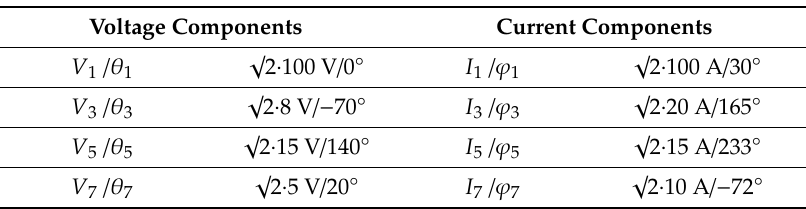
Table 2. Numerical values of magnitude and phase angle.